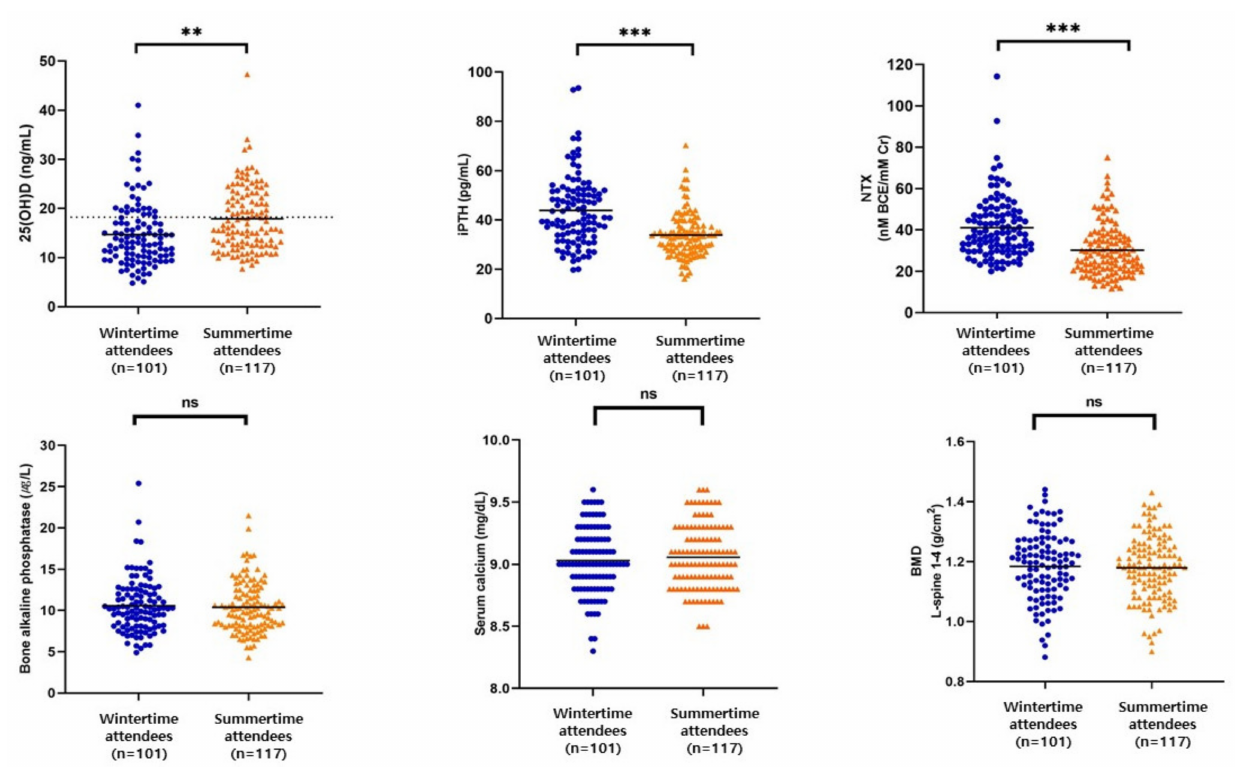
Figure 1. Scatter plots of bone turnover markers and bone mineral density. Solid line: mean value, dotted line on the 25(OH)D graph: 20 ng/mL; iPTH, intact parathyroid hormone; NTX, type I collagen cross-linked N-telopeptide; BMD, bone mineral density; *** p < 0.001, ** p < 0.01, ns: not